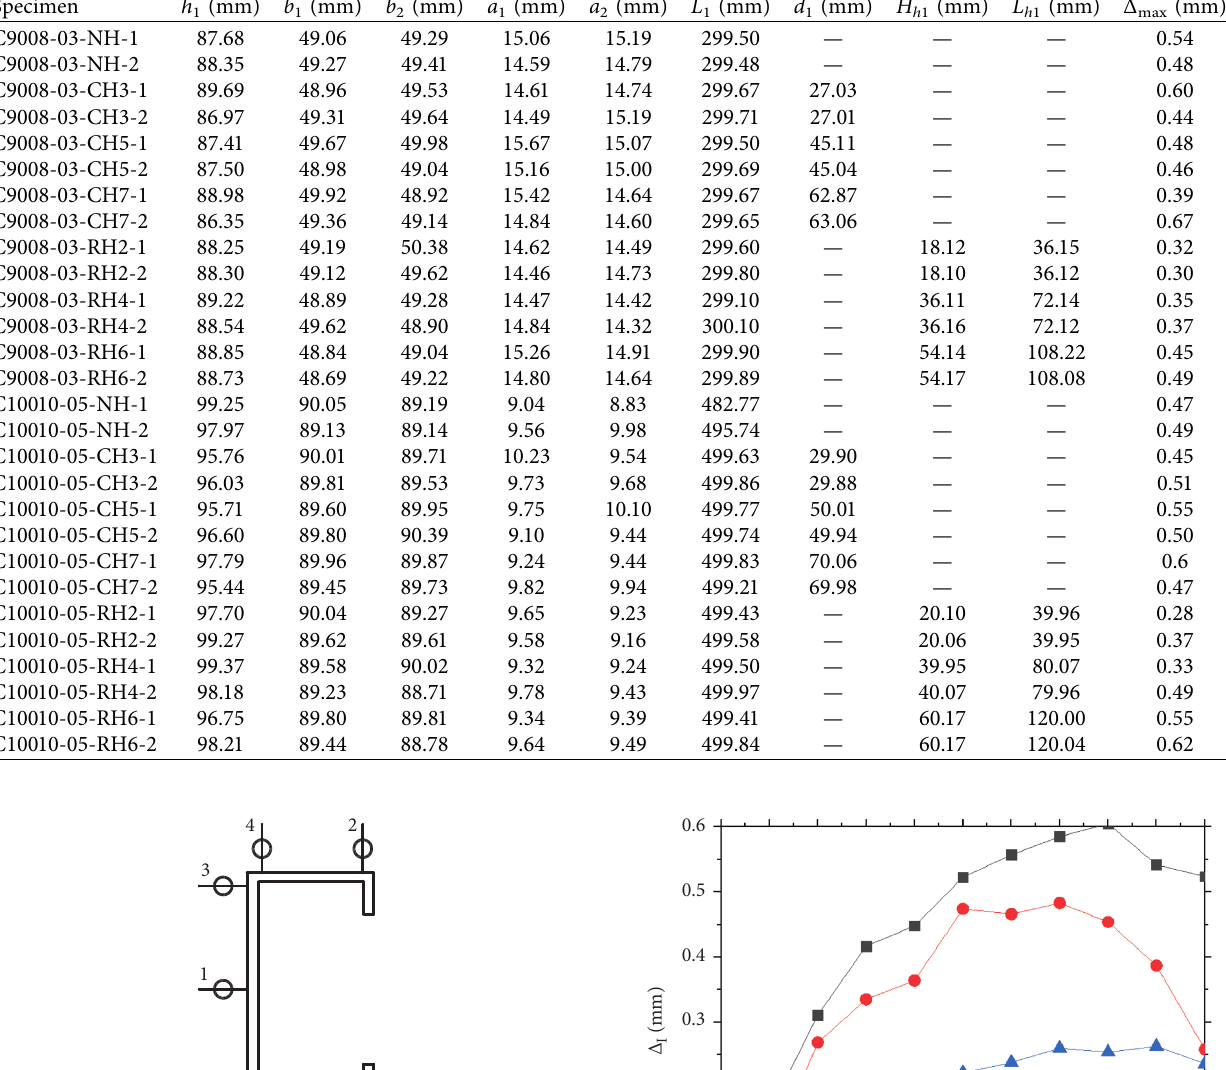
Table 2: Measured dimensions of tested stud